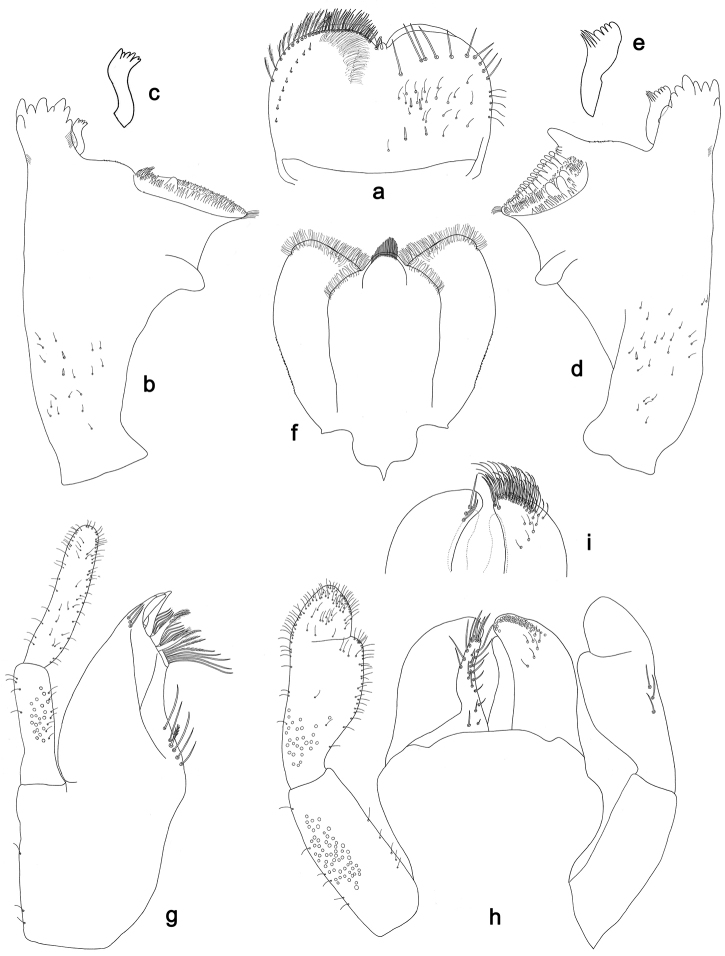
Labiobaetisrutschmannae sp. n., larva morphology: a Labrum b Right mandible c Right prostheca d Left mandible e Left prostheca fHypopharynxg Maxilla h Labium.